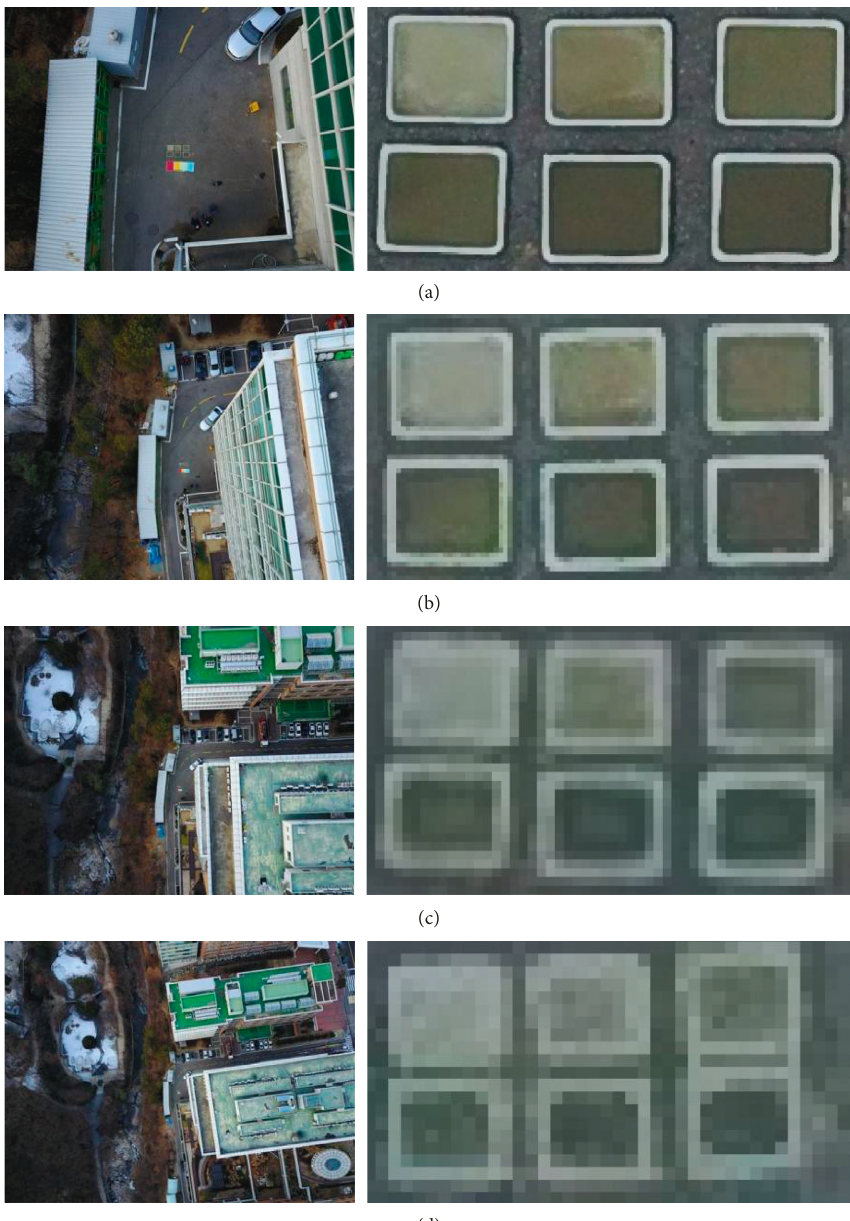
Figure 5: Aerial photographs of the soil surface using the UAV. Altitude: (a) 20 m; (b) 50 m; (c) 100m; (d)